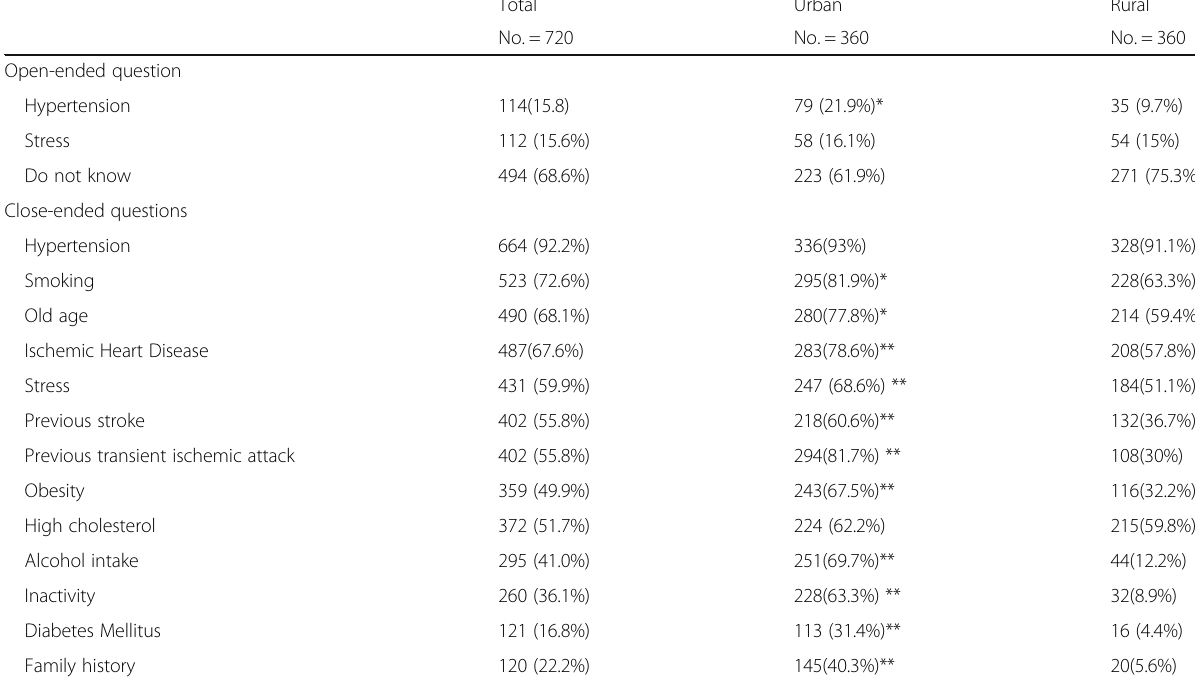
Table 3 Knowledge of the risk factors of cerebro-vascular stroke among urban and rural participants